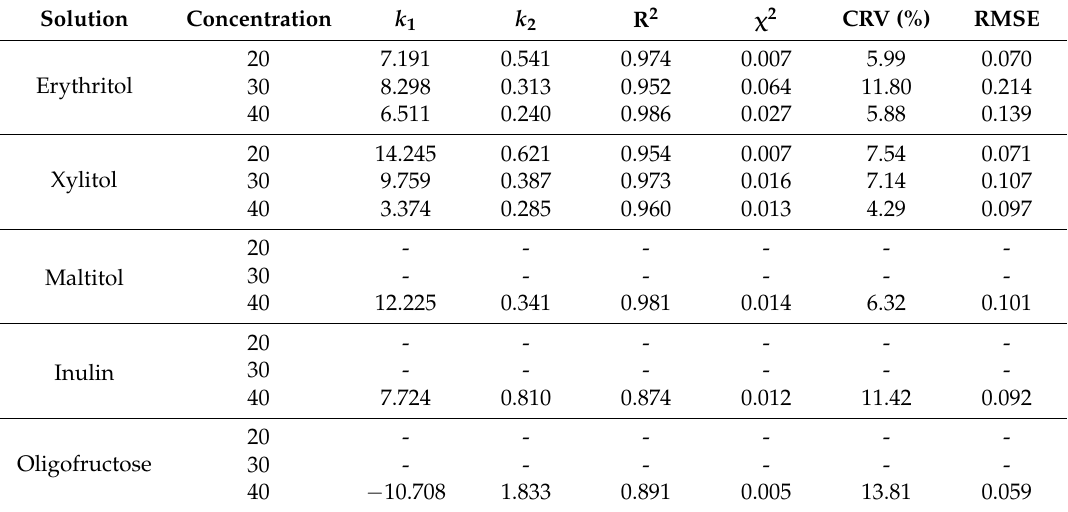
Table 4. Values of k 1 , k 2 , R 2 , χ 2 , CRV and RMSE of modeling WL using Peleg’s model.